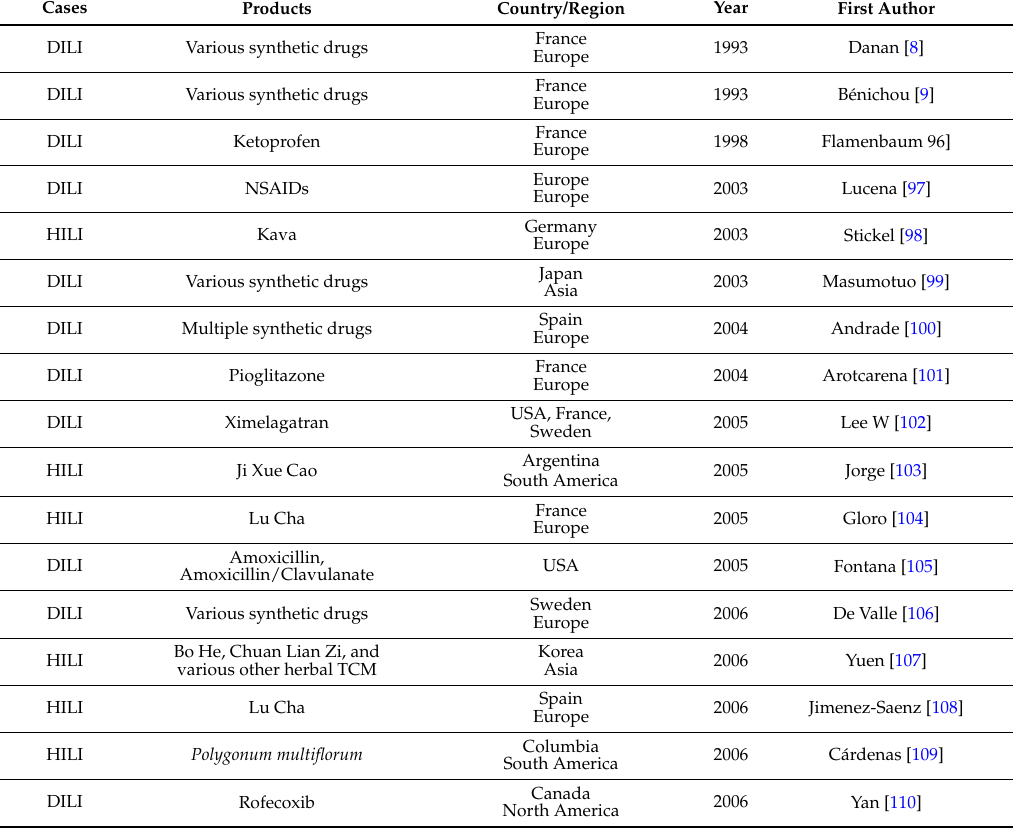
Table 8. Listing of selected individual reports using RUCAM in suspected DILI and HILI